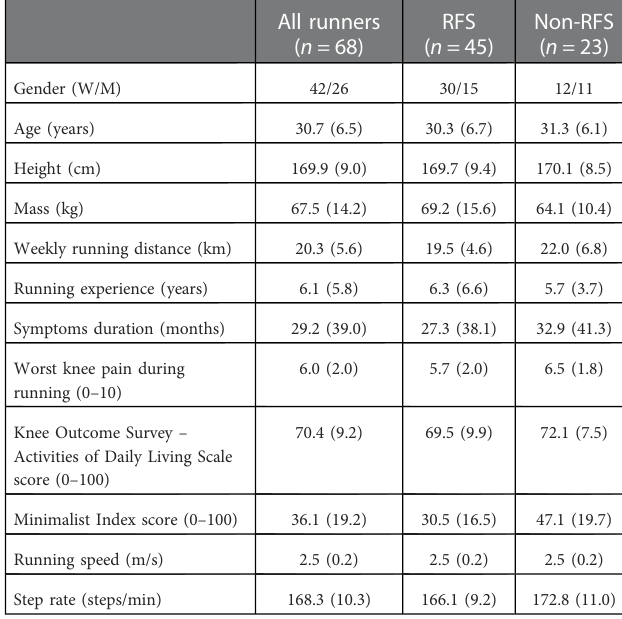
TABLE 1 Characteristics of runners. Data presented as Mean (SD)